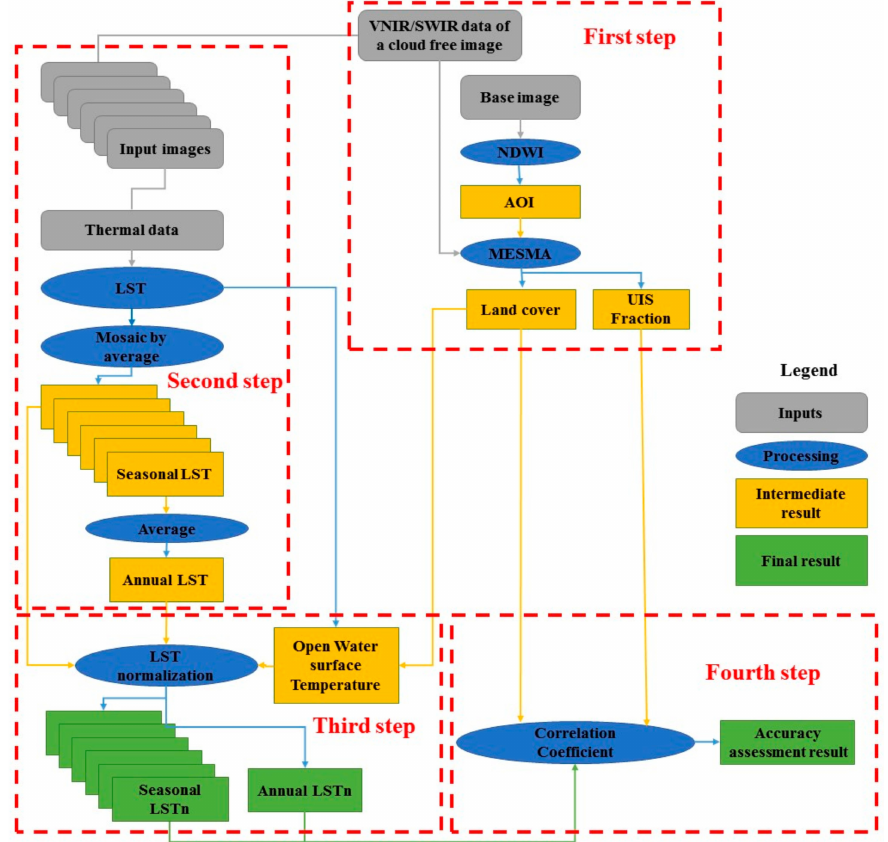
Figure 1. Workflow of the LSTn